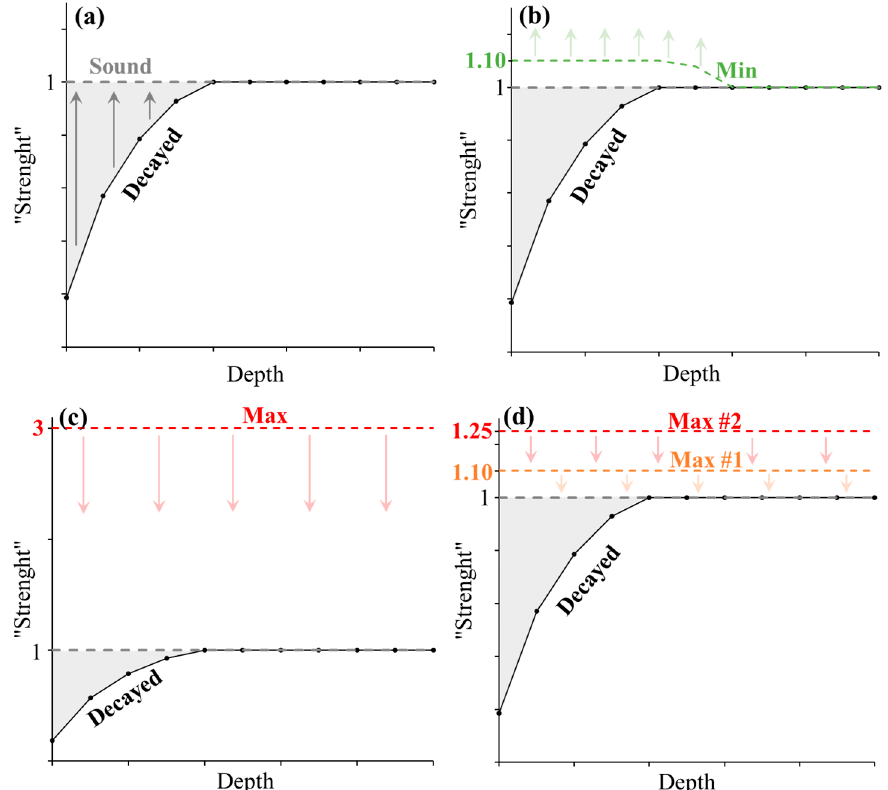
Figure 6. Different recommendations for adequate consolidation actions illustrated by schematic “strength” profiles: ( a ) restoration of the original strength; ( b ) treated portion of stone has at least 10% more strength than sound stone [137]; ( c ) maximum consolidation is 3 times the strength of sound stone [4]; ( d ) consolidation should not exceed the value of sound stone by more than 25%, preferentially below 10% [159] .